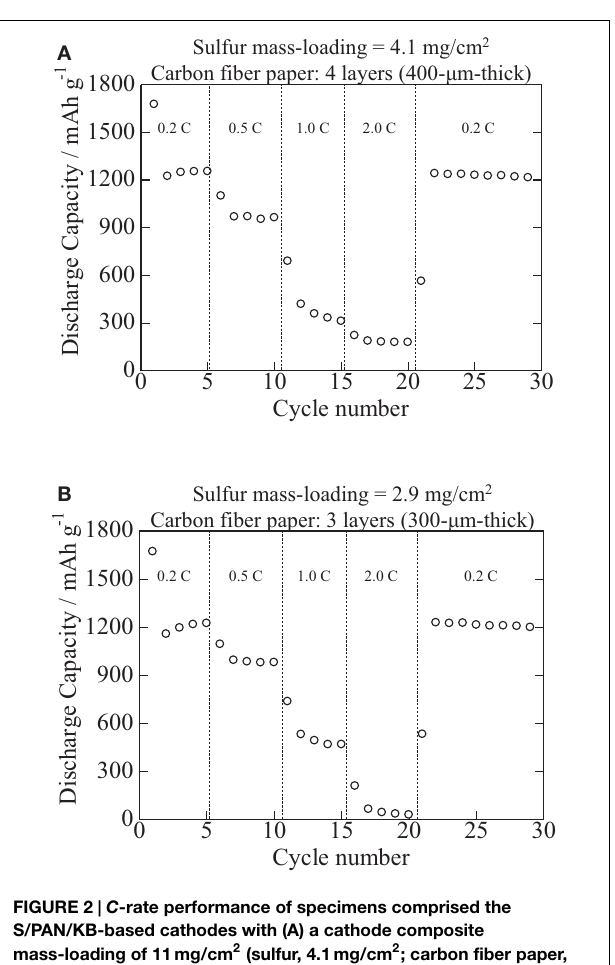
( Figure 1A ) a cathode composite mass-loading of 11 mg/cm 2 (sulfur, 4.1 mg/cm 2 ) and ( Figure 1B ) a cathode composite mass- loading of 7.7 mg/cm 2 (sulfur, 2.9 mg/cm 2 ) that were cast into